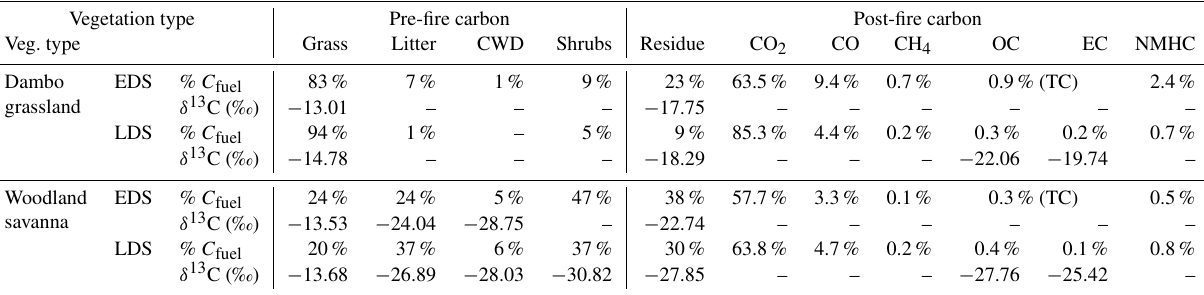
Table 3. Weighted-average carbon allocations measured in prescribed burns during the early dry season (EDS) and late dry season (LDS). Pre-fire carbon was allocated to grass, litter, shrubs, and coarse woody debris (CWD) and post-fire carbon to residue (ash, char, and unburned fuels), CO 2 , CO, CH 4 , organic carbon (OC), elemental carbon (EC), and non-methane hydrocarbon (NMHC) gases. The latter was estimated from emission ratios in the